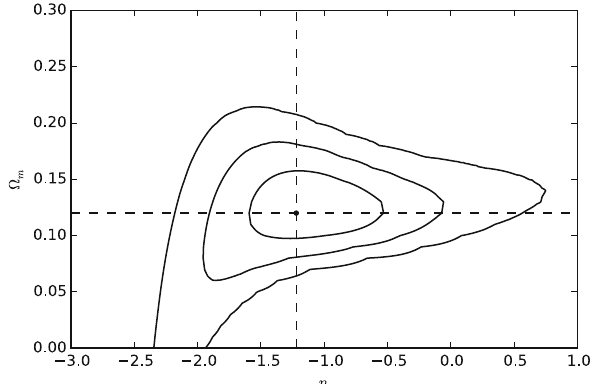
Fig. 4 The 1 σ , 2 σ and 3 σ confidence regions of the effective param- eters n , Ω D 0 m , marginalizing H D over the interval [50, 90], where the 0 best-fits are n = − 1 . 22, and Ω D 0 m = 0 . 12 Fig. 3 a The evolution of q D with best-fit values of n = 0.03, and Ω D 0 m ( z ) with the same best-fit values as in = 0.25; b The evolution of w D eff ( a ); c The relation between κ D ( z ) and z with the same best-fit values as in ( a ); d The evolution of Ω D m (solid line) and Ω D (dashed line) with X the same best fits as in ( a )